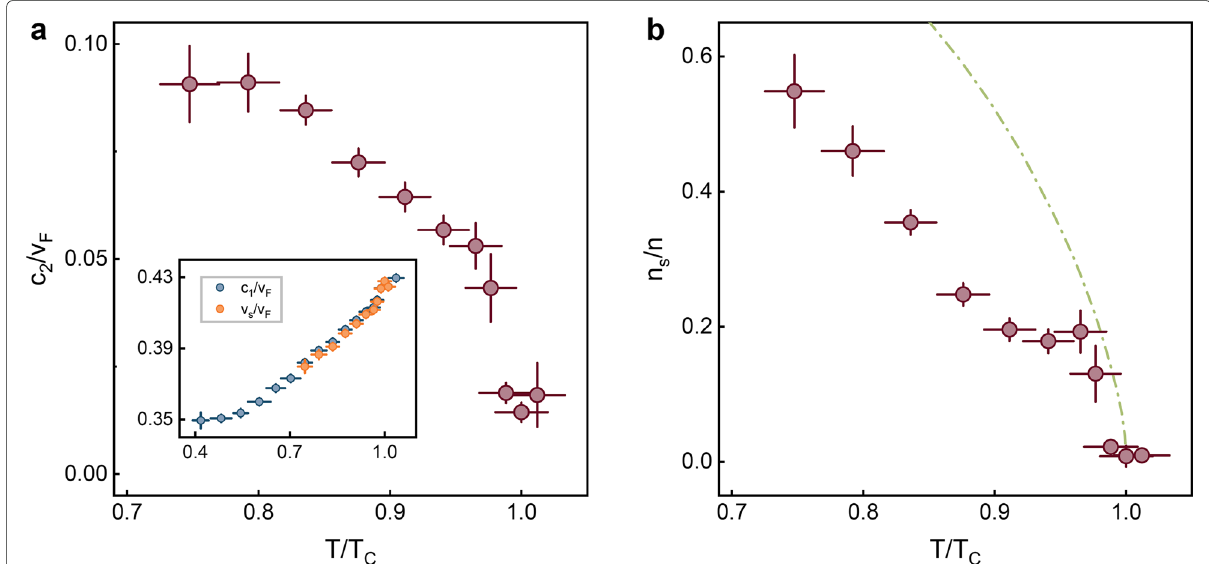
Fig. 15 a Temperature dependence of the normalized first-sound speed c 1 / v F (blue dots in the inset) and second-sound speed c 2 / v F (red dots), obtained from the curve fitting of density response spectra Fig. 14. Here, v F = (cid:2) k F / m is the Fermi velocity. The inset also shows the adiabatic sound (cid:18) speed v S / v F (orange dots), calculated by using v S = c 2 1 + c 2 2 − v 2 . b Temperature dependence of the superfluid fraction n s / n , compared with that of superfluid helium (green dash-dotted line). Adapted from Ref. [33]